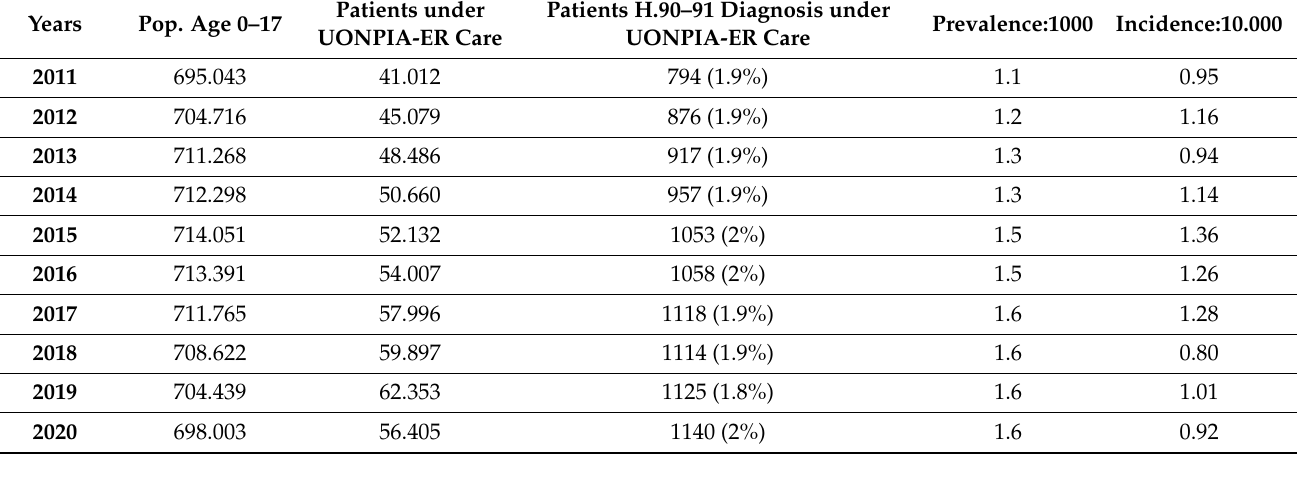
Table 1. Prevalence and incidence of hearing loss in the juvenile population and in CAMHS users. Due to small numbers, incidence was measured as 1:10,000 instead of 1:1000.